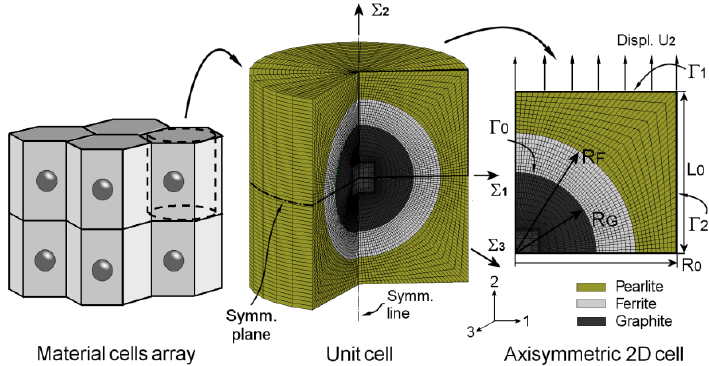
Figura 6: Modellazione della ghisa nodulare mediante cella assialsimmetrica, [35].